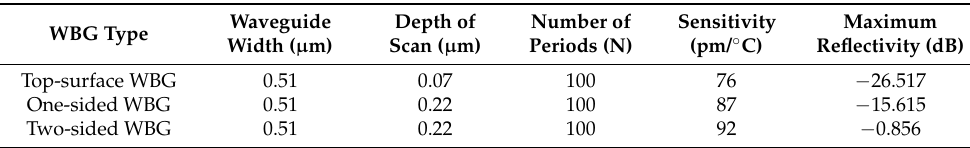
Table 1. Summary of simulation results of silicon-based WBG.